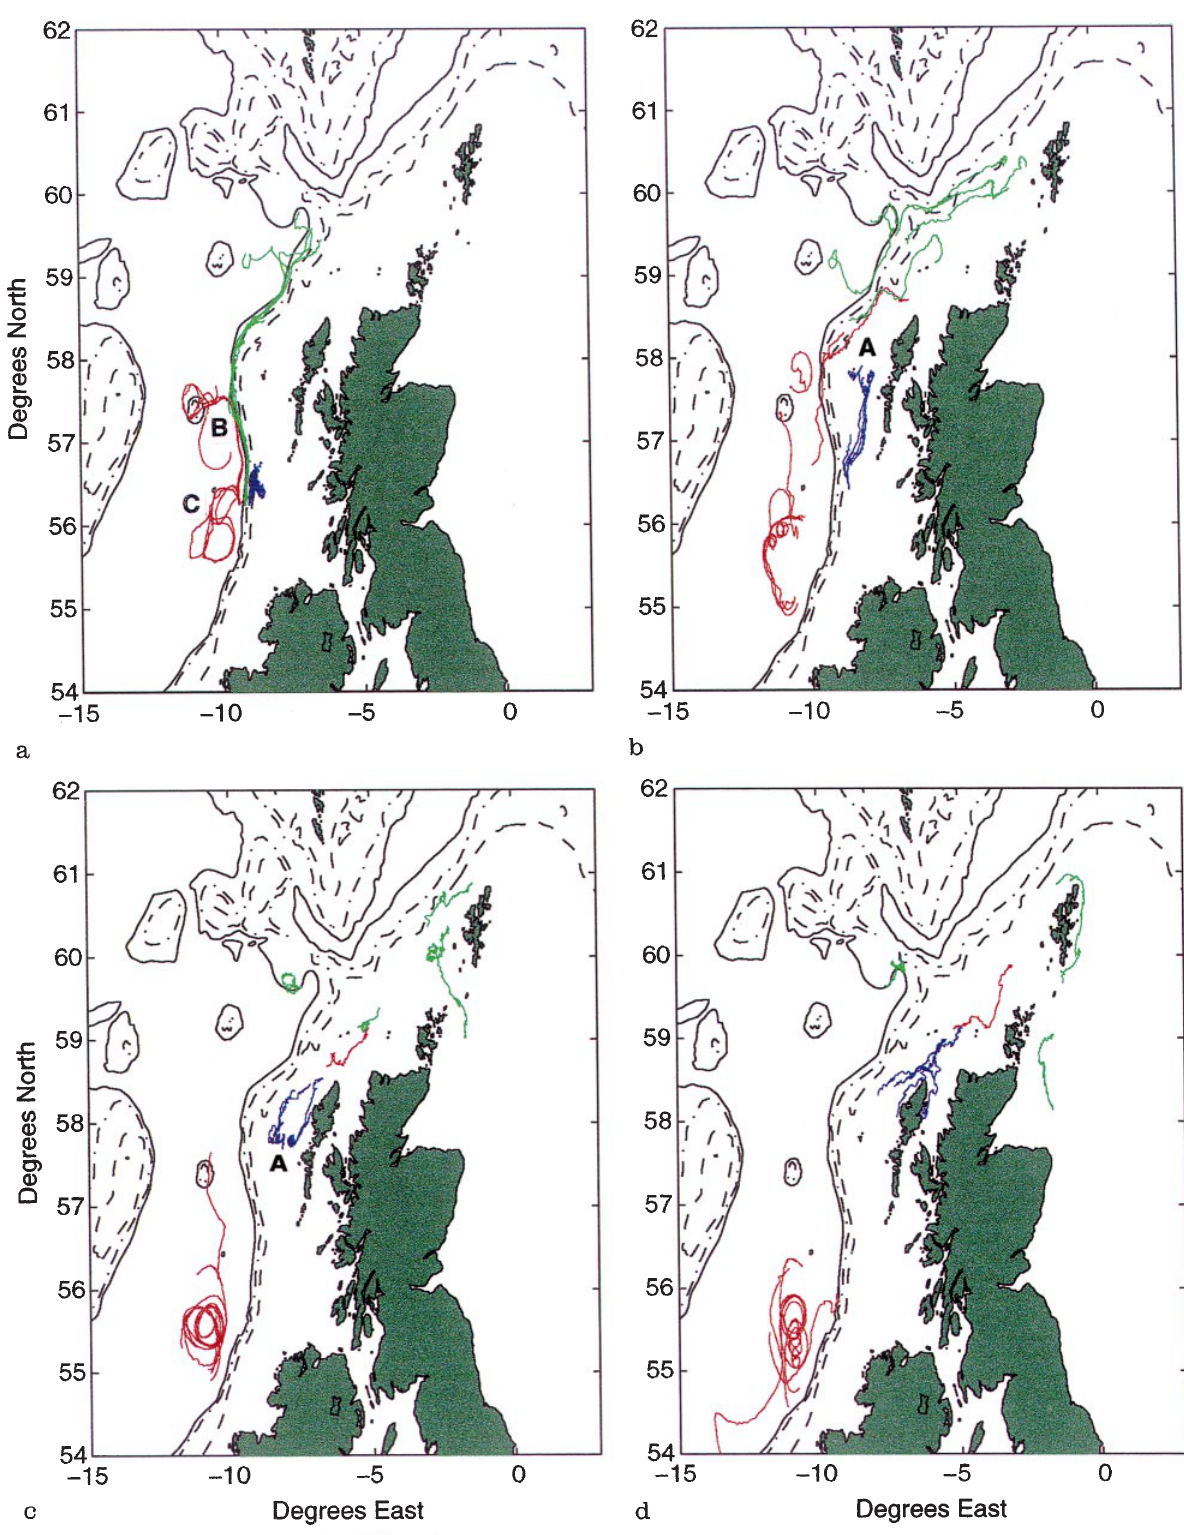
Fig. 4a–e. Drifter tracks after the summer deployment on 5–9 May 1996, in 25 day sections. The frames remain on the same scale but are in other respects identical to Fig. 3. C , In a marks dispersion near the